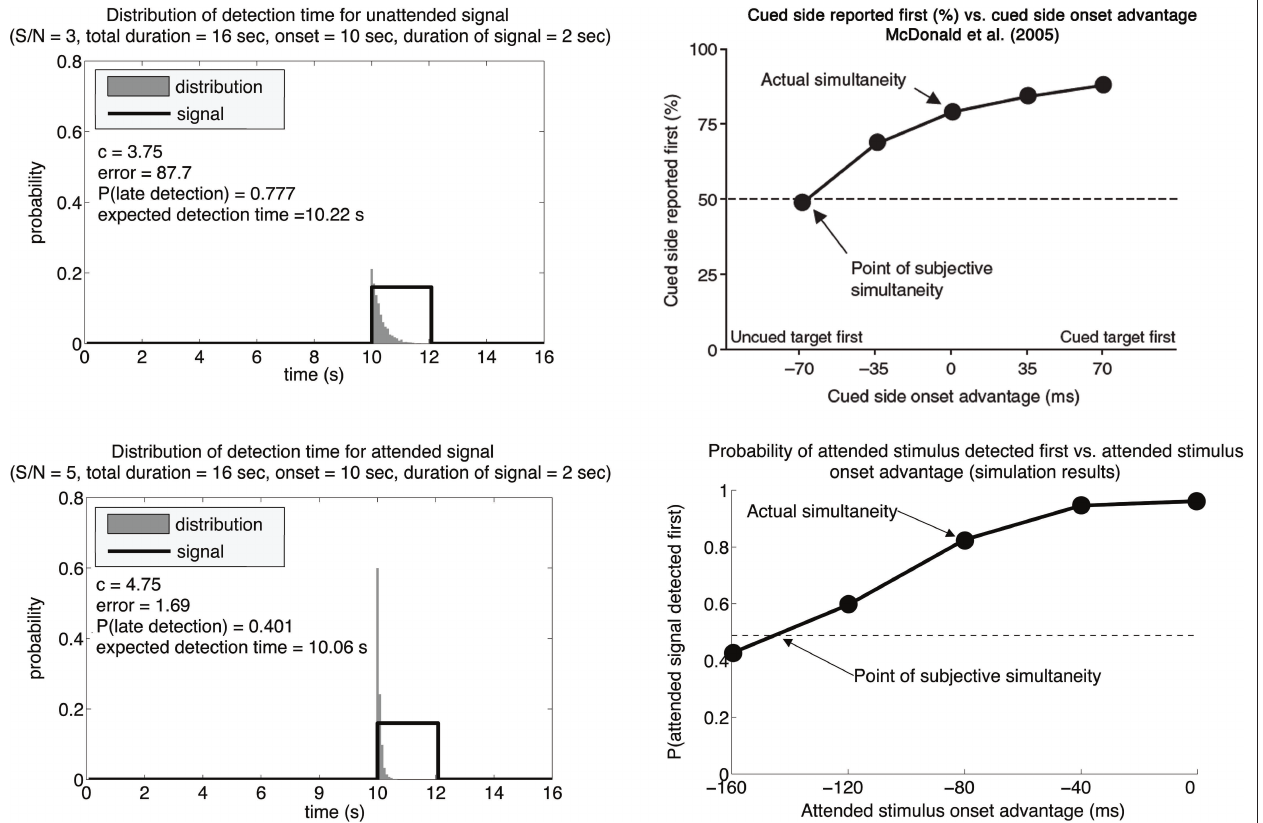
Figure 3 | Left panels: We set the duration of the trial epoch to 16 s and the signal onset to the 10th second of the trial epoch. The signal was a step function with signal-to-noise ration of either 3 (upper panel) or 5 (lower panel) simulating an unattended and an attended condition. In the former case the optimal criterion was c = 3.75 resulting in 220 ms delay for the onset estimate; in the latter case the optimal criterion was c = 4.75 resulting in 60 ms delay for the onset estimate. This shows that lower signal-to-noise ratios result in later optimal estimates of the signal onset. Right panels: Data